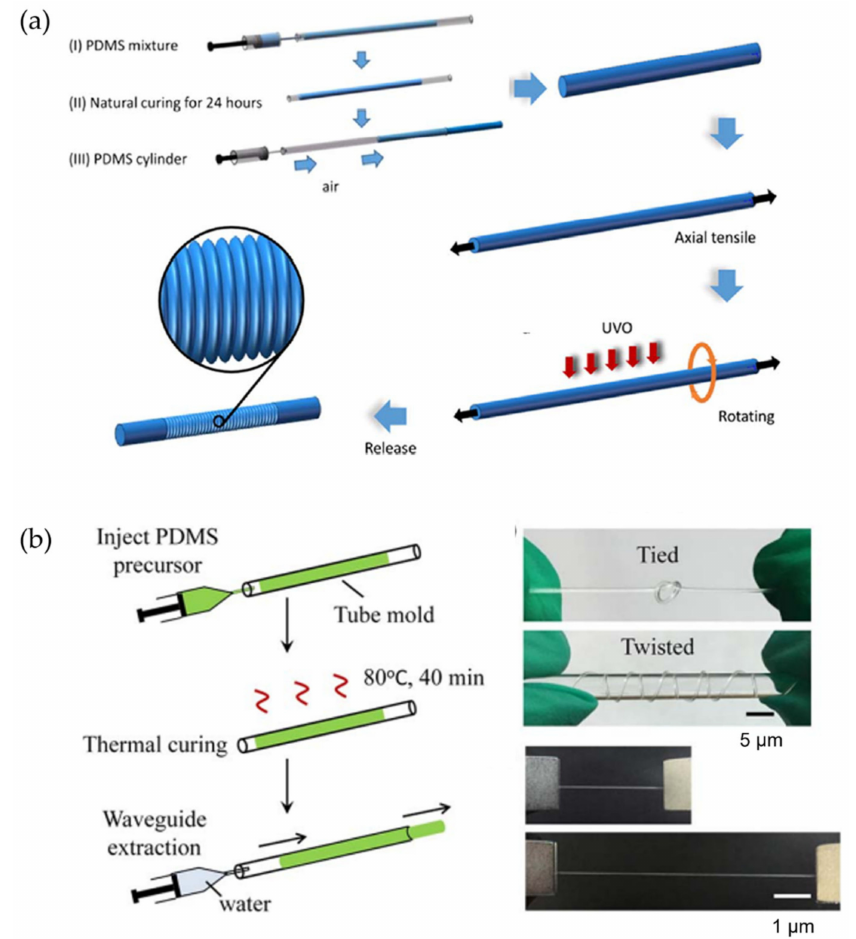
Figure 26. ( a ) Wrinkled PDMS cylinder preparation process and ( b ) fabrication and testing of the mechanical flexibility of the PDMS fibers. Reproduced with permission from references